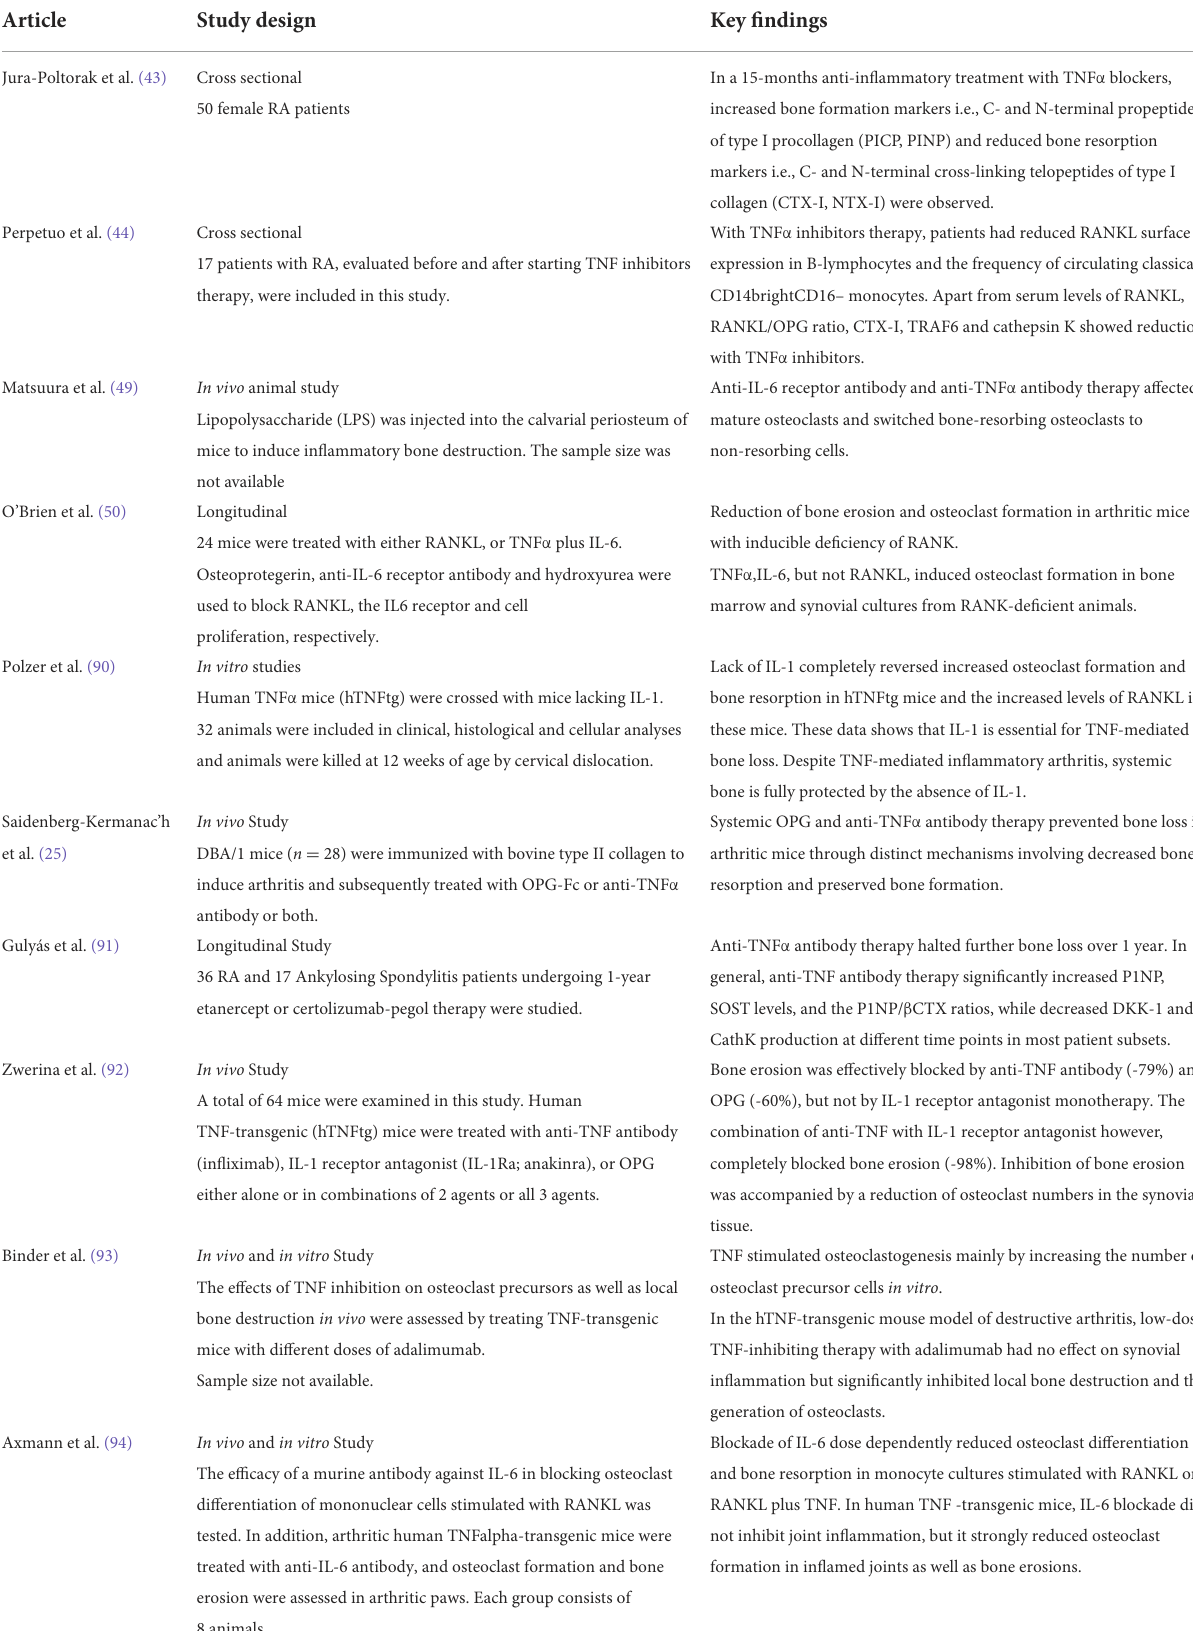
TABLE 2 Recent studies on cytokines-related bone loss in